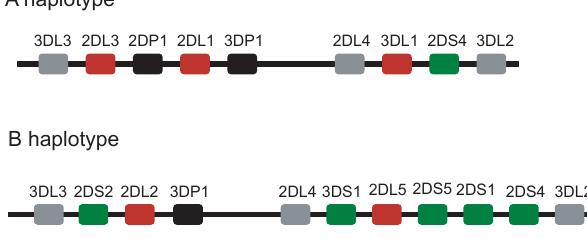
Figure 1. Organization of the KIR gene cluster. The KIR gene order is shown for the A haplotype and a representative B haplotype. Inhibitory KIR genes are shown as red boxes, whereas the activating genes are shown in green. The framework genes are indicated by grey boxes, and pseudogenes are indicated by black boxes. Each gene spans between 10–16 kb, and the intergenic distances are approximately 2 kb with the exception of the 14 kb region upstream of the KIR2DL4 gene.